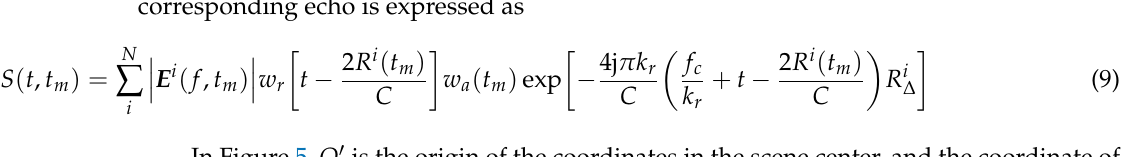
Figure 5. Geometry of spotlight SAR image. Based on the raw echo data S ( f , t m ) in Equation (8), the residual video phase (RVP) can be removed via multiplying by a linear phase function H RVP ( f ) = exp m Then, transforming the result into the range time domain by means of the inverse FFT, the corresponding echo is expressed